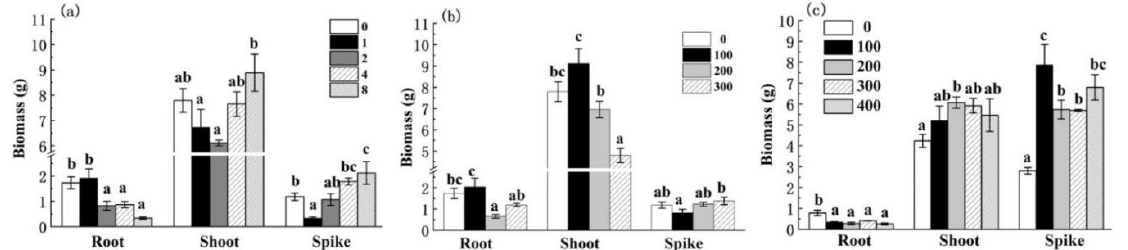
Figure 1. Biomass of all parts of sea rice in different Cd ( a ), Cu ( b ), and Zn levels ( c ). Lowercase letters on the bar chart indicate significant differences among different treatments ( p < 0.05). Data were presented as mean ± standard error (n = 3).